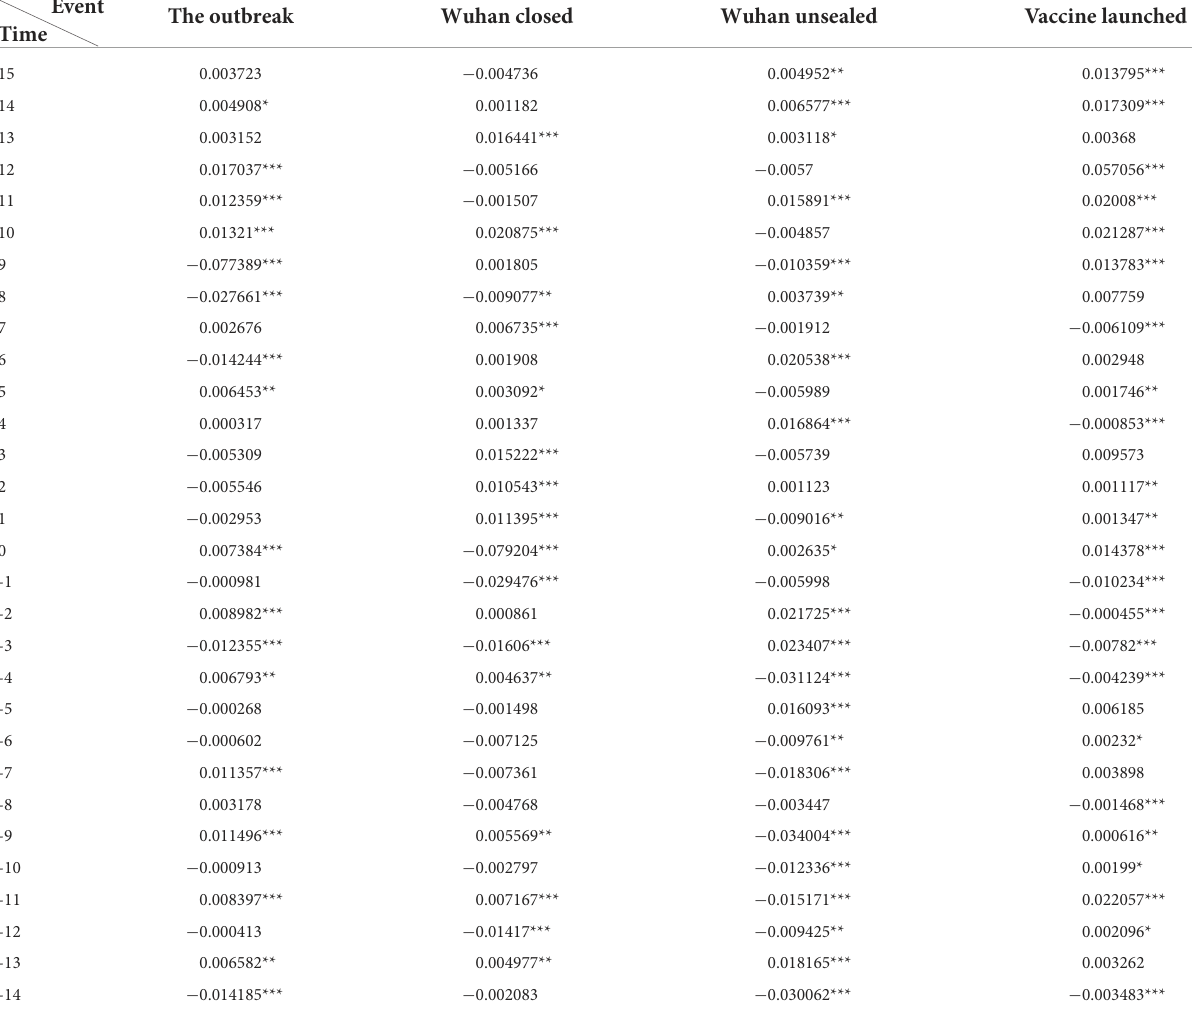
TABLE 1 Abnormal returns: